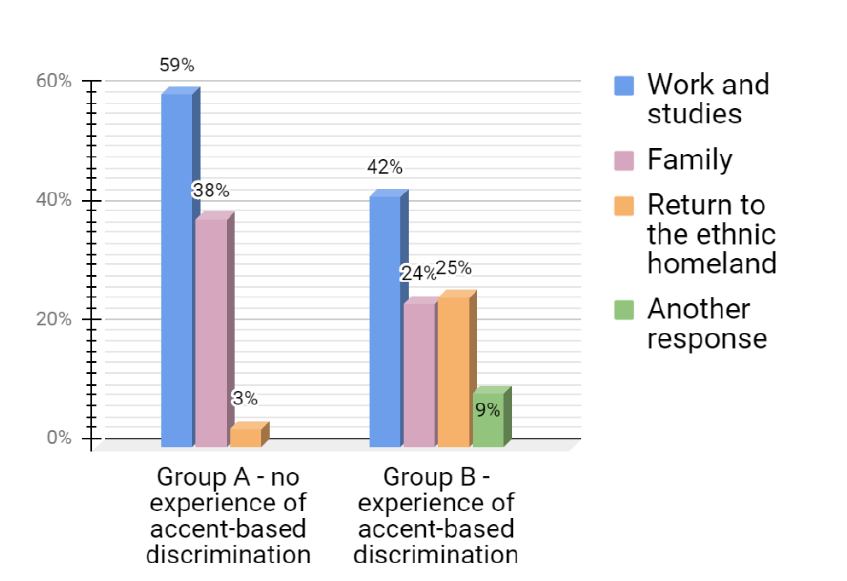
Fig.2 — Comparative characteristic of purposes of immigration to